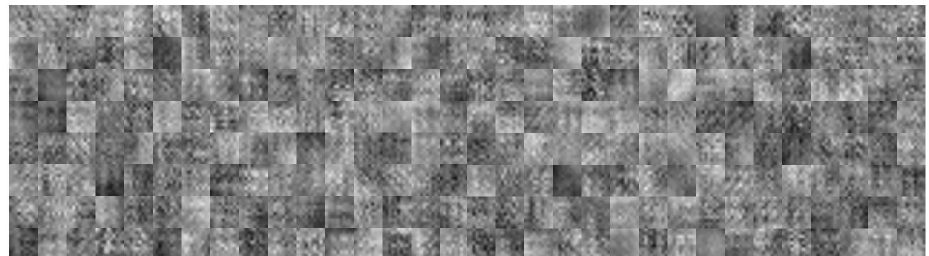
Figure 12. Visualization of C1 layer weights learned by USresNet.